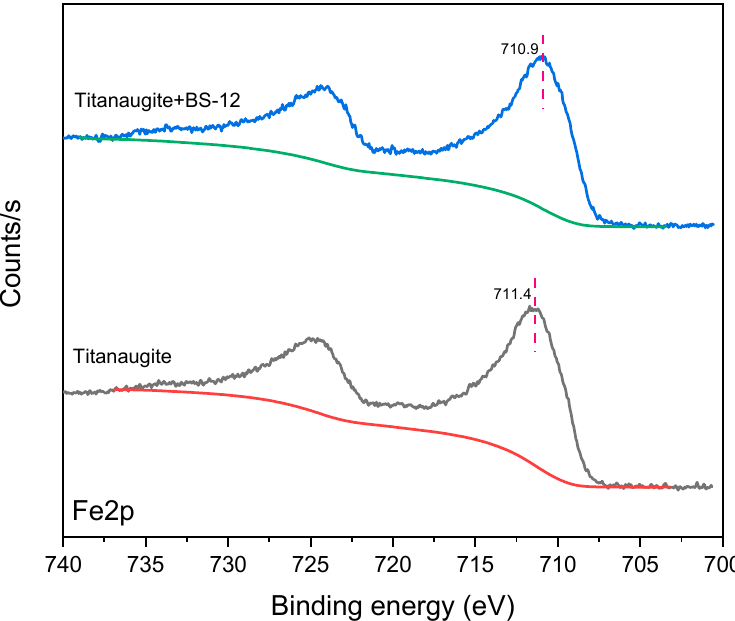
Figure 10. High-resolution spectra of Fe2p, before and after BS-12 treatment.